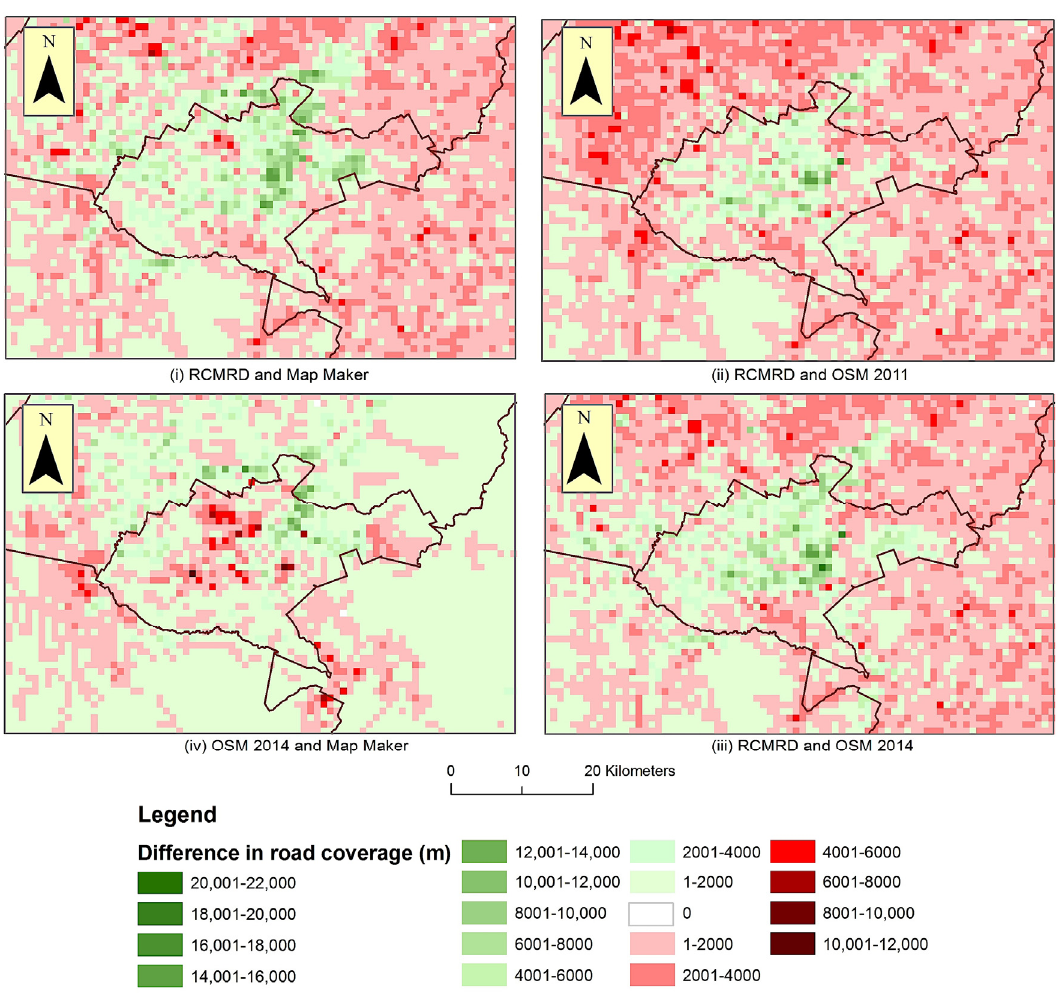
Figure 5. Pairwise difference in road coverage. Clockwise from top left: ( i ) RCMRD 2011 vs. Map Maker 2014; ( ii ) RCMRD 2011 vs. OSM 2011; ( iii ) RCMRD 2011 vs. OSM 2014; ( iv ) OSM 2014 vs. Map Maker 2014 (red cells: first layer has higher coverage; green cells: second layer has higher coverage).